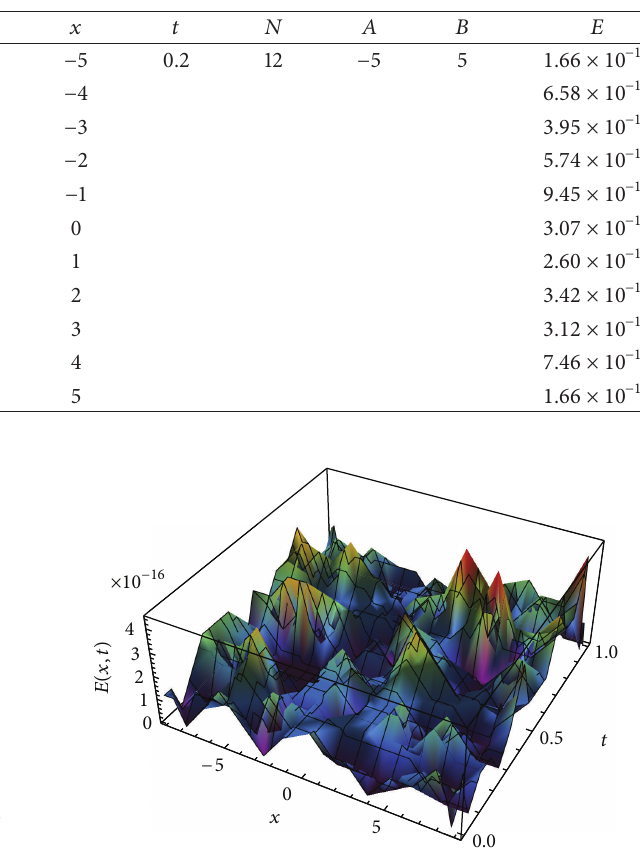
Table 7: Absolute errors with 𝜃 = 𝜗 = 0 , 𝑁 = 40 and various choices of 𝑥,𝑡 with 𝜏 = 0.5 for Example 4.